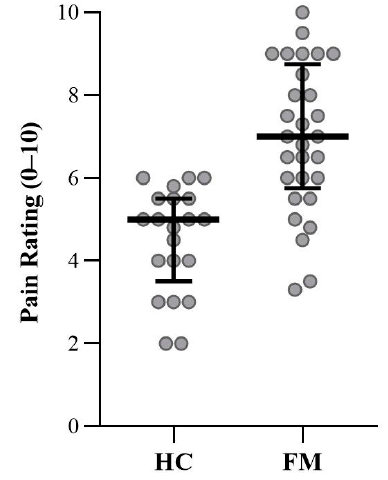
Figure 1. Subjective pain ratings in the fibromyalgia patients ( n = 29) and healthy controls ( n = 21).